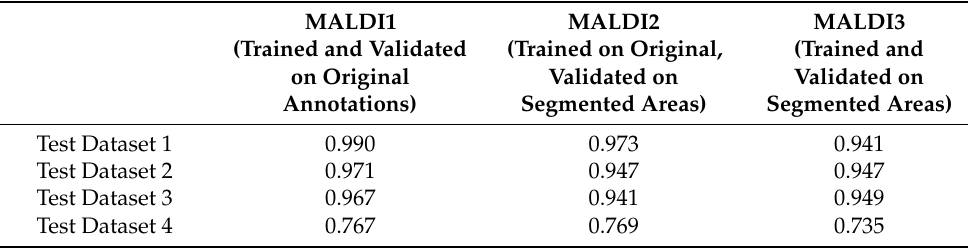
Table 4. Balanced accuracies of different MALDI networks for different test datasets on spectra level . Note that the values are based on the assumption that all spectra included in each dataset represent the true tumor type of the respective section, neglecting the fact that Datasets 2, 3, and particularly 4 contain spectra from non-tumor regions. MALDI1 MALDI2 MALDI3 (Trained and Validated (Trained on Original, (Trained and on Original Validated on Validated on Annotations) Segmented Areas) Segmented Areas) Test Dataset 1